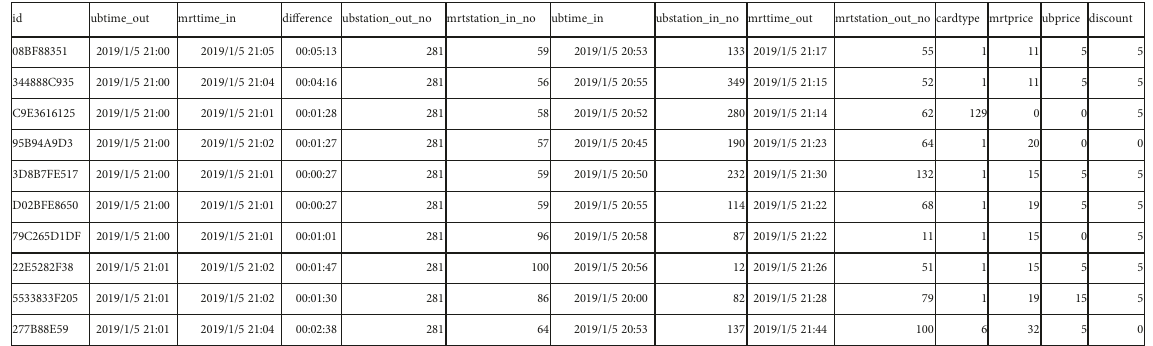
Figure 5: An example of merged data for YouBike-MRT transfers.